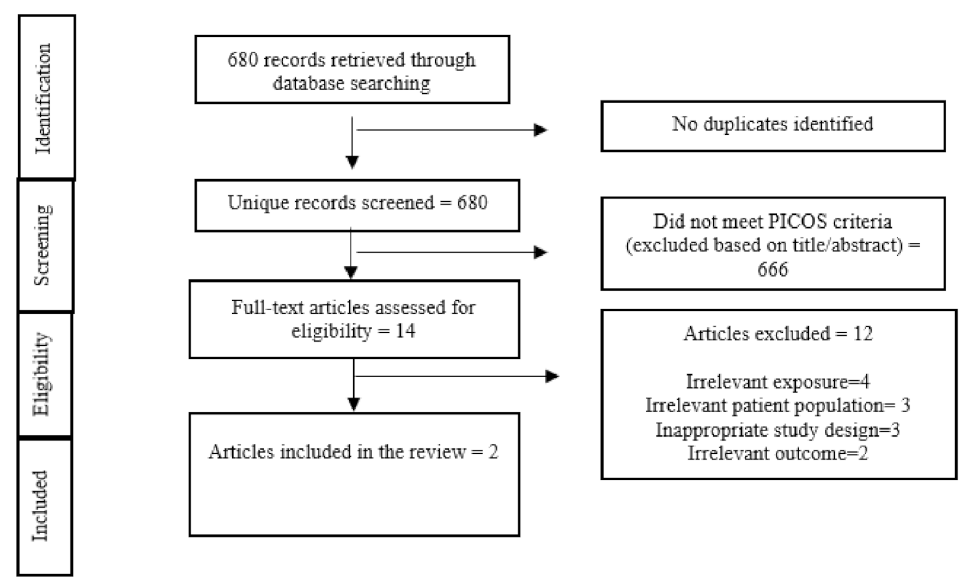
Figure 1. Flow diagram of included